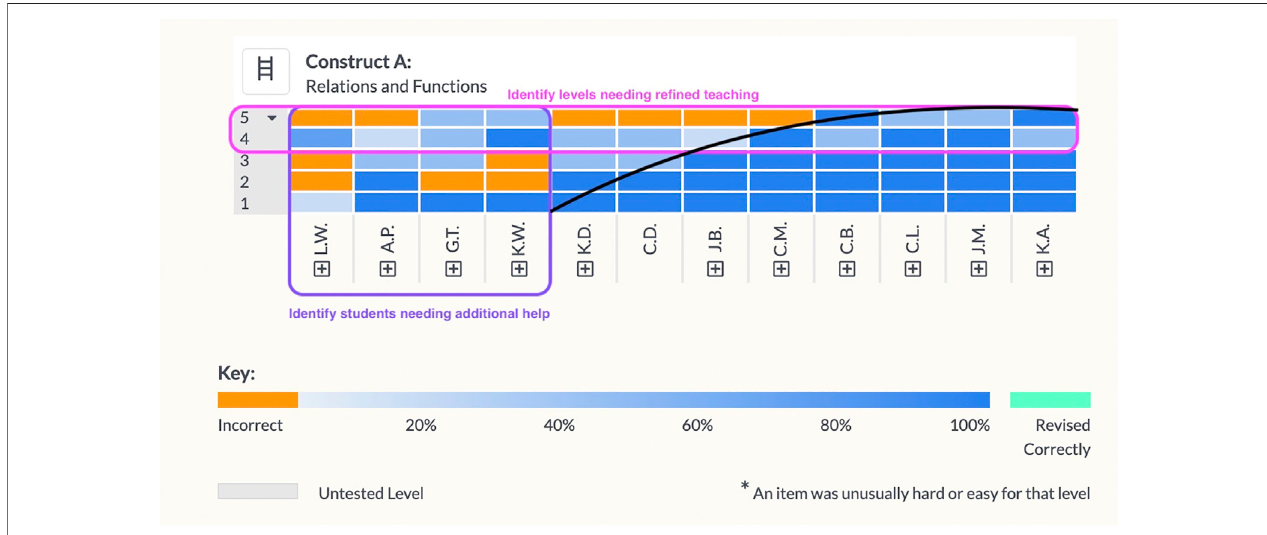
FIGURE 2 | Class report: heatmap of the Relations and Functions the LT. Vertical axis: levels of LT, ordered from low (bottom) to high (top) . Horizontal axis: studentpseudonymsordered byoverallconstructscore,fromlow (left) tohigh (right) .Eachcell represents asinglestudent ’ sscoreonanitem measuring